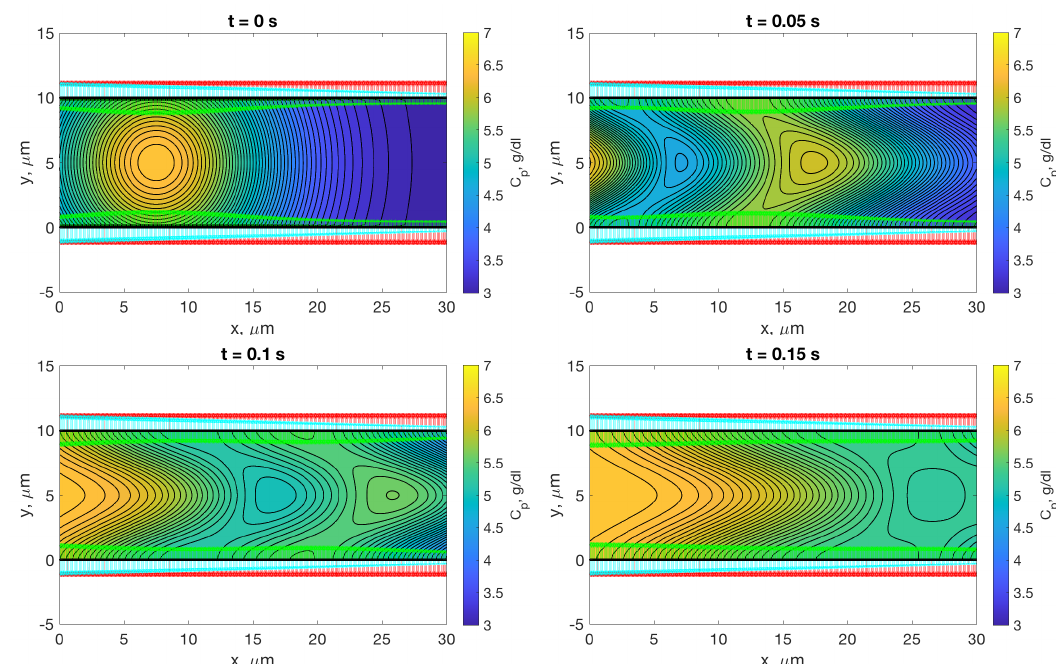
Figure 9. Advection of concentration of plasma protein, C p , in a permeable channel with a constant velocity profile at the left boundary. Sources of concentration include an initial gaussian of concentration in the channel which is then added to by a constant protein concentration introduced at the left boundary. Red arrows indicate the velocity due to the hydrostatic pressure, P hyd , while green arrows indicate that due to the colloid osmotic pressure Π g . Thus, these velocities are greatest where the concentration is largest, and change with the transport of the concentration. Cyan indicates the net flow due to both pressures in addition to the force exerted by the fluid moving with the velocity at the left boundary. The net velocity is scaled by 5 so as to be visible, when it is dwarfed in comparison to the velocities due to Π g and P hyd . All three velocities are scaled by 2 for visibility.